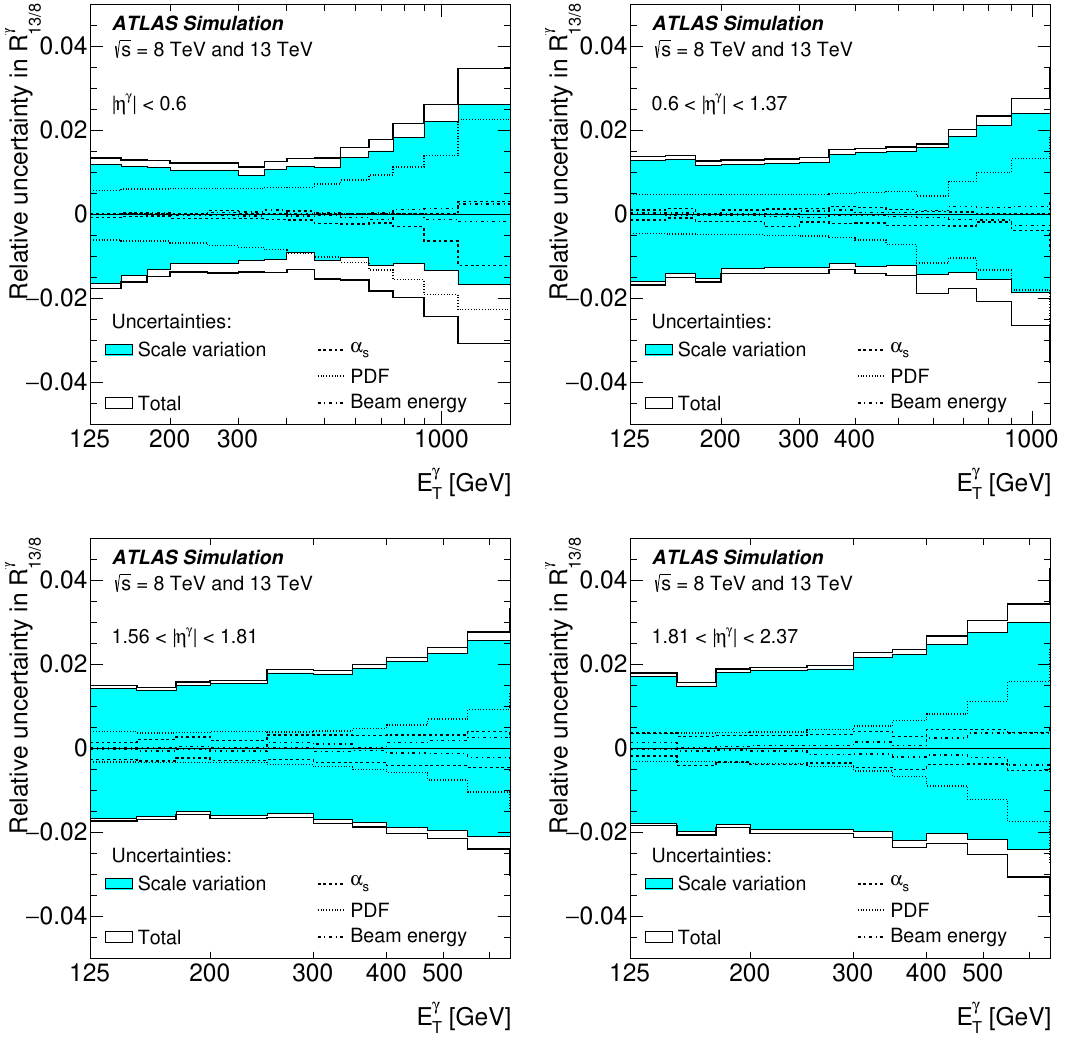
Figure 1 . Relative theoretical uncertainty in R (cid:13) arising from the scale variations (shaded area), the value of (cid:11) s (dashed lines), the PDF (dotted lines) and the beam energy (dot-dashed lines). The total theoretical uncertainty is shown as the solid